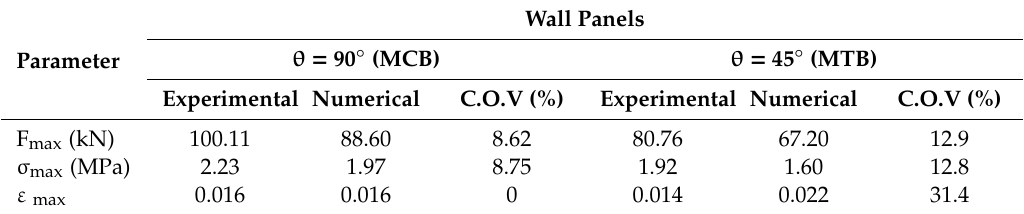
Figure 12. Experimental and numerical curves of stress–strain relationship of unreinforced walls. Table 11. Comparison of numerical result with experimental data.